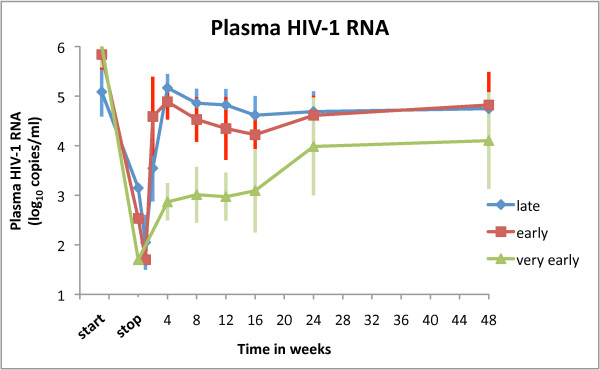
Plasma HIV-1 RNA load. The mean plasma HIV-1 RNA load versus time in weeks after interruption of HAART for patients classified in late (21 subjects), early (22 subjects) and very early (11 subjects) groups. Error bars show standard deviations. The features of the three clinical settings are given in section Patients and Methods.